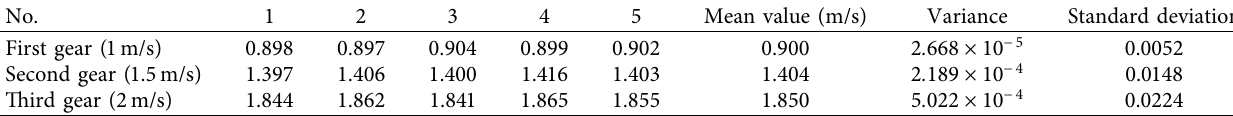
Table 7: High-load linear speed of the combine